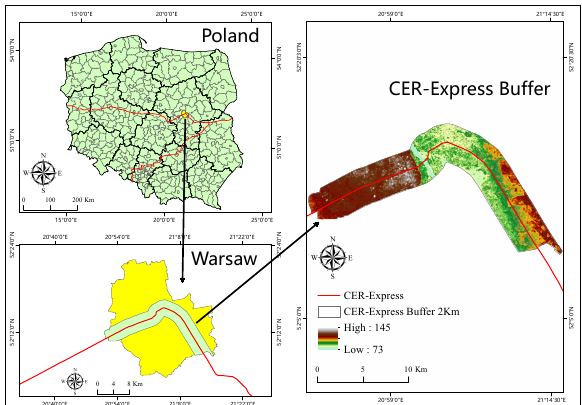
Fig.1. The location of the study